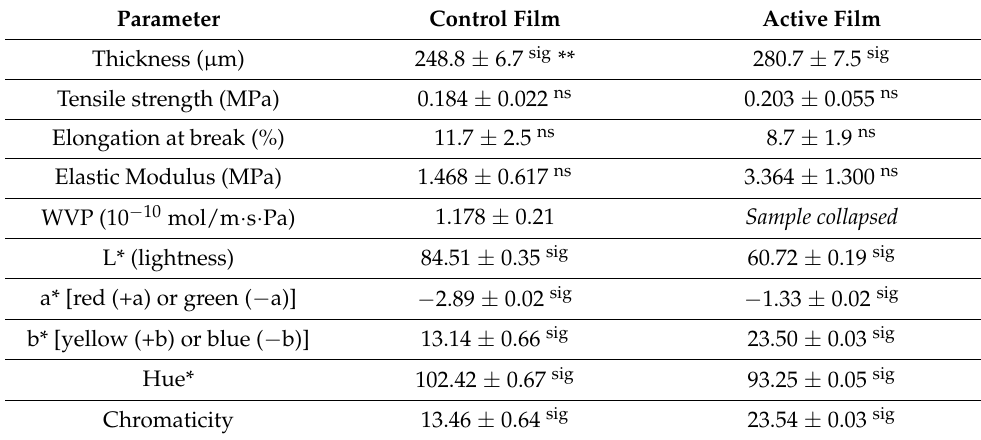
Table 2. Film characterization. Results are the means ± standard deviation of the